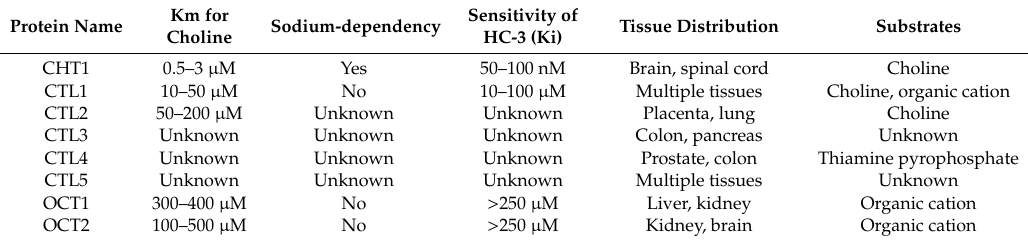
Table 1. Properties of choline